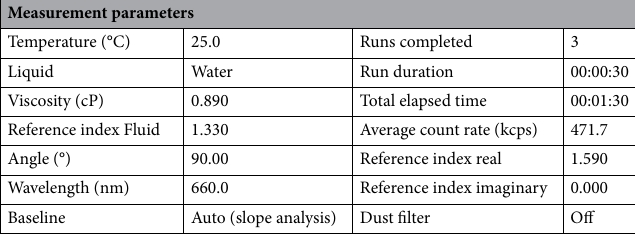
Table 4. The parameters of the particle size distribution measurements.